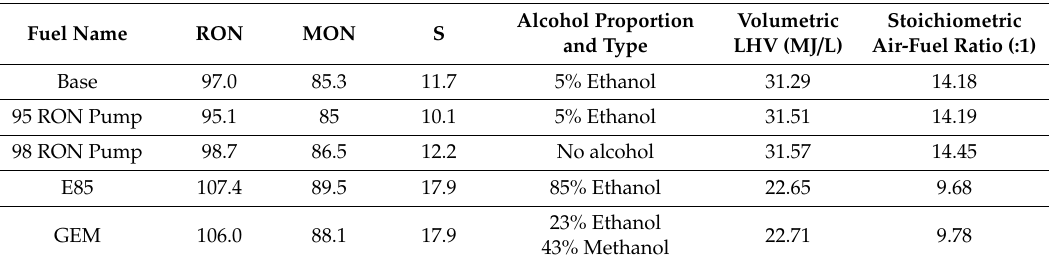
Table 2. Specifications of the gasoline, E85, and ternary gasoline-alcohol “GEM” fuels tested in the Ultraboost extreme downsizing demonstrator engine. All data was supplied by Shell and measured using standard industry test procedures and